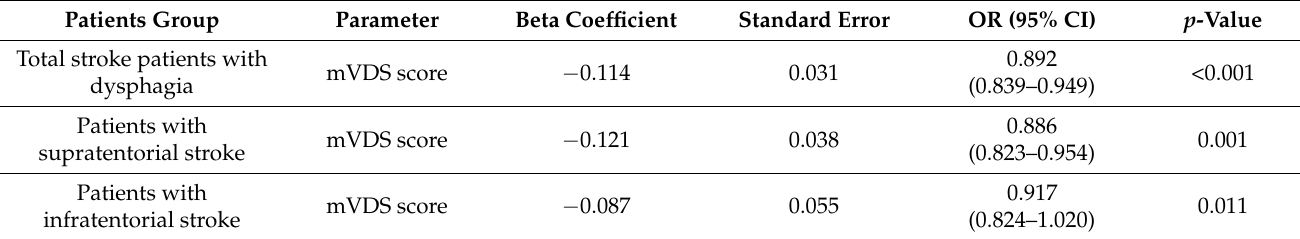
Table 3. Univariate logistic regression analysis (with the enter method) of the association between the modified version of the Videofluoroscopic Dysphagia Scale scores and the selection of the oral feeding